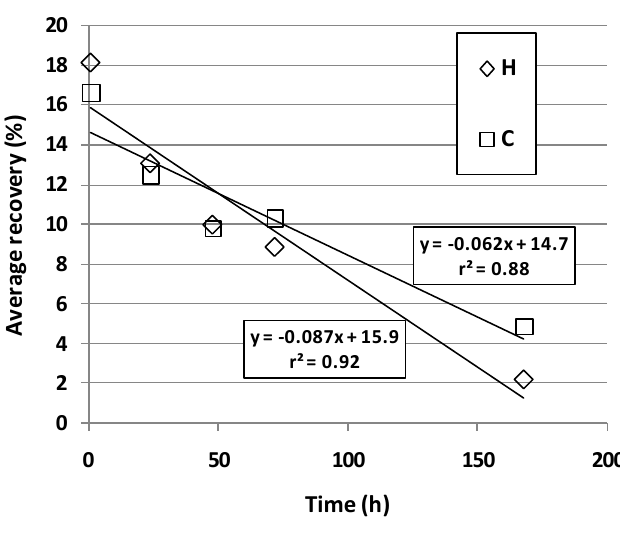
Figure 1. Average recovery of eight VOCs over a period of 168-h (7-d) since time of filling for homemade (H) and commercial (C) Tedlar PVF